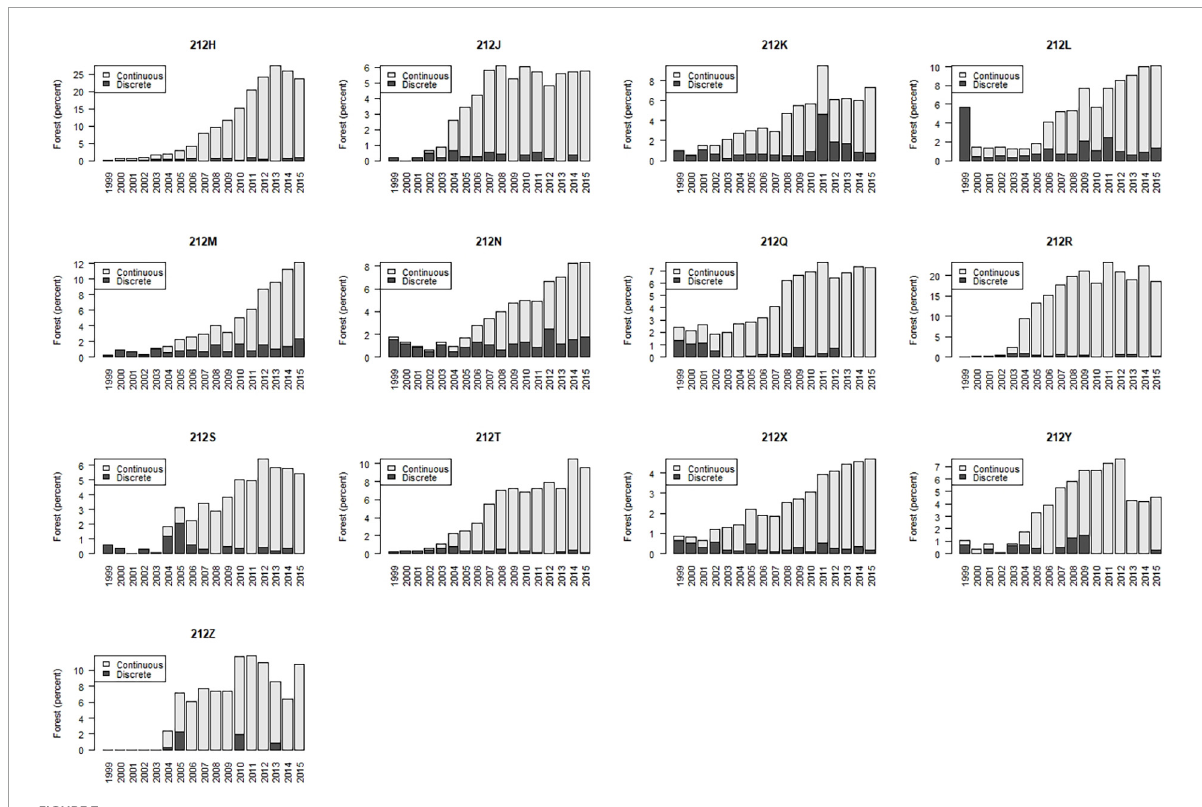
FIGURE7 Annual disturbance by ecological section 1999–2015.